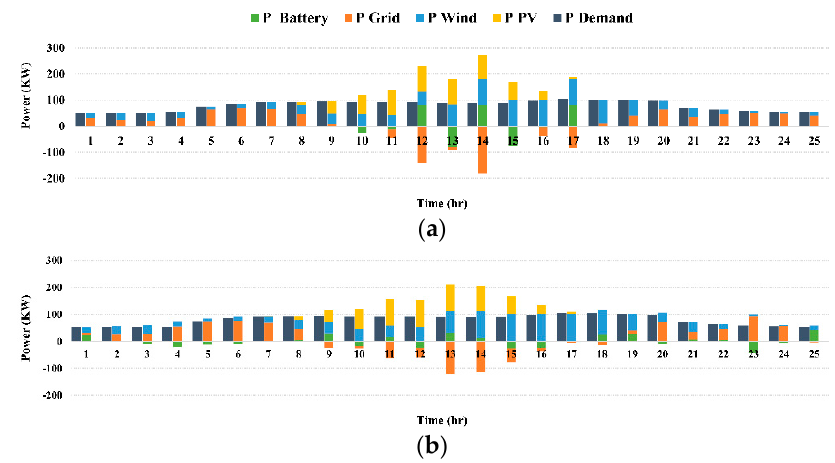
Figure 9. Power schedule ( a ) without interior search algorithm (ISA) and ( b ) with ISA.